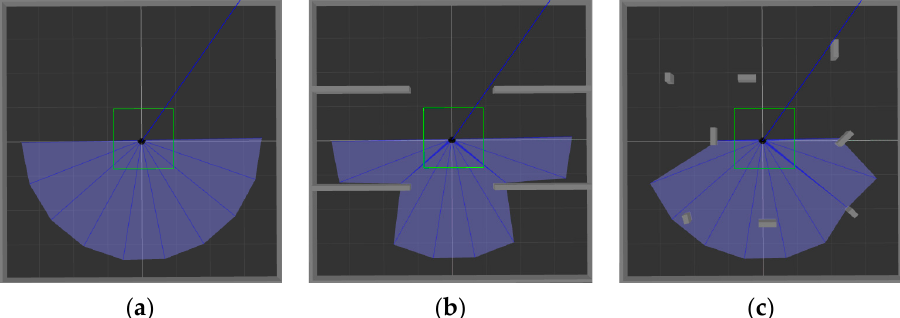
Figure 6. Schematic diagram of the simulation environment established by Gazebo7. ( a ) There are no obstacles in the environment; ( b ) there are large obstacles in the environment; ( c ) there are ran- domly generated small obstacles in the